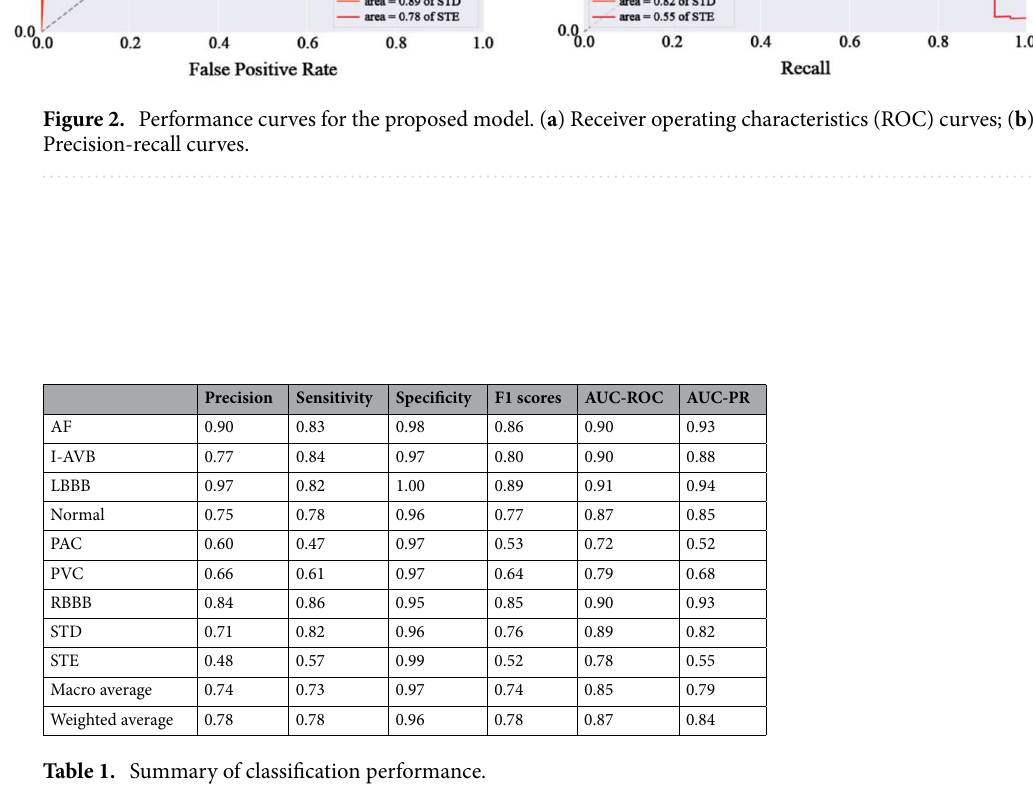
Table 1. Summary of classification